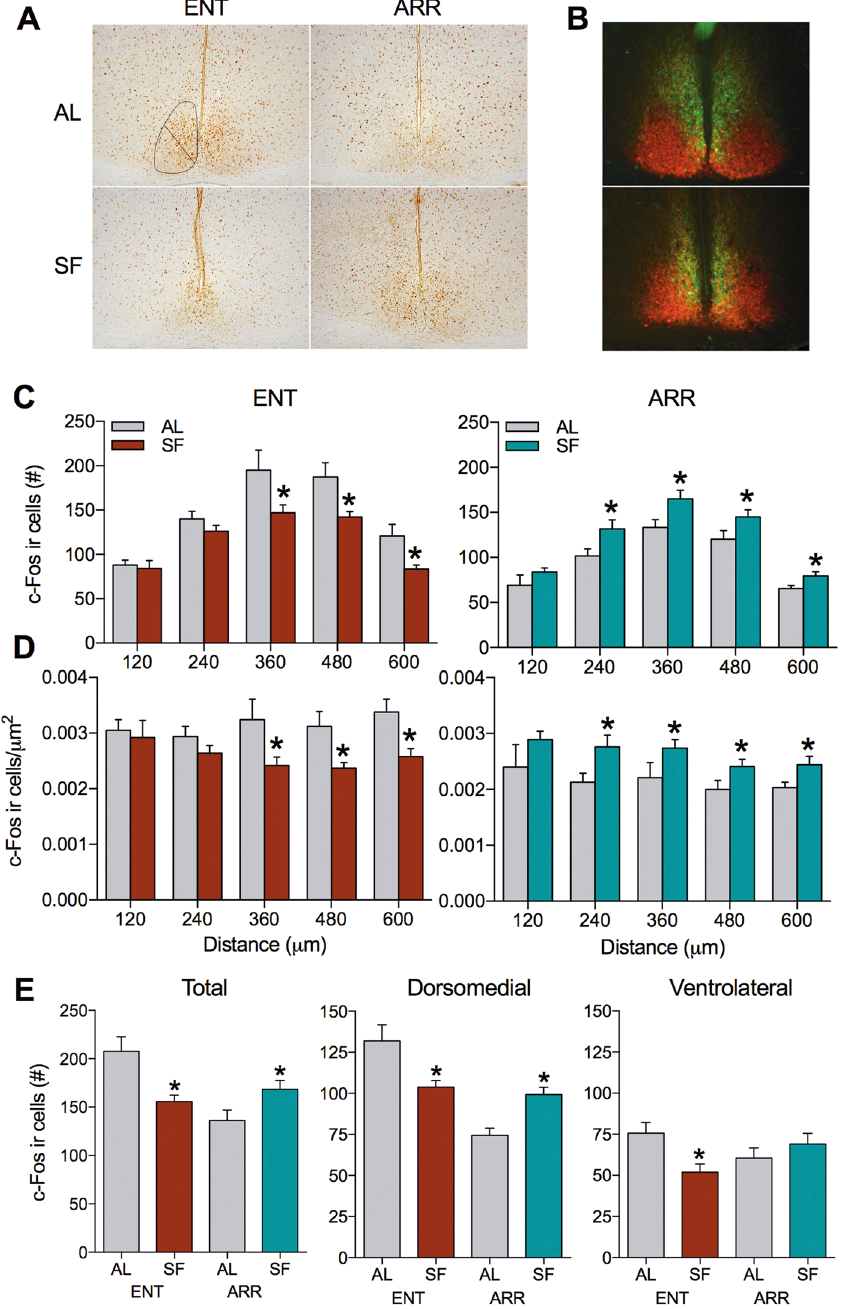
Figure 3. Induction of c-Fos expression in the SCN occurred primarily in the dorsomedial region along the mid to caudal SCN axis. ( A ) Representative tissue sections showing typical patterns of c-Fos expression in entrained (ENT) and in DPS-arrhythmic (ARR) animals that underwent either the scheduled feeding (SF) regimen or were fed ad libitum (AL). ( B ) Representative tissue sections from the mid (upper section) and caudal (lower section) SCN showing patterns of immunoexpression of vasopressin-neurophysin (green) and vasoactive intestinal polypeptide (red). These sections were used as templates for demarcating dorsomedial and ventrolateral SCN boundaries for the cell counts. ( C ) Number of cells counted at sequential levels of the SCN along its rostrocaudal axis. Sections were taken at intervals of 120 μ m ( * indicates significant differences between AL and SF conditions; P < 0.05, n = 6 per group). ( D ) Data from C given as density of c-Fos IR cells. ( E ) Number of c-Fos IR cells in the dorsomedial and ventrolateral subregions of the SCN, as well as total cell counts ( * indicates P < 0.05 compared to AL